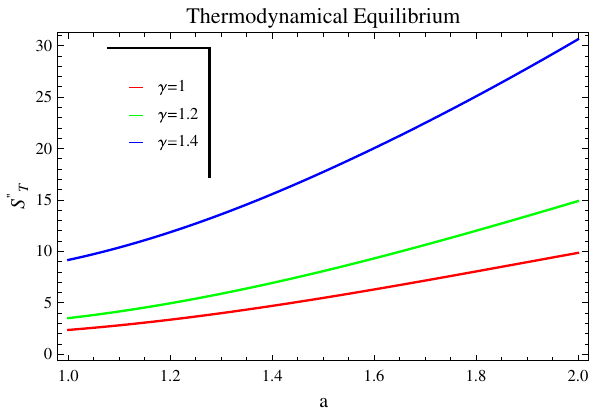
Fig. 12 Plot of S (cid:7)(cid:7) versus a for Renyi entropy using k = 1 , λ = T − 1 , η = 1 and b = 1